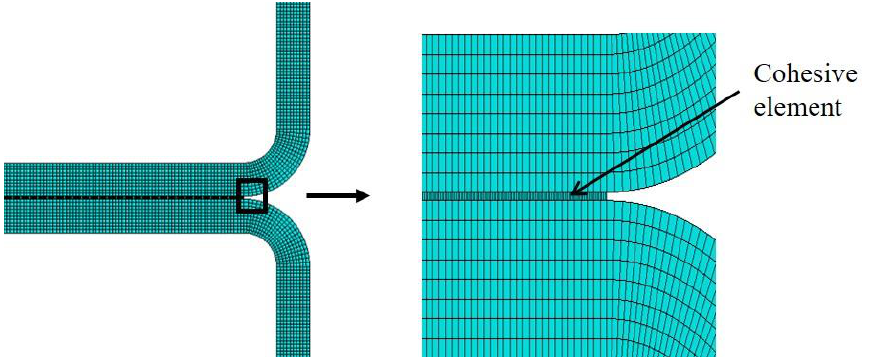
Figure 7. Finite element meshing of the brazed T-type specimen.